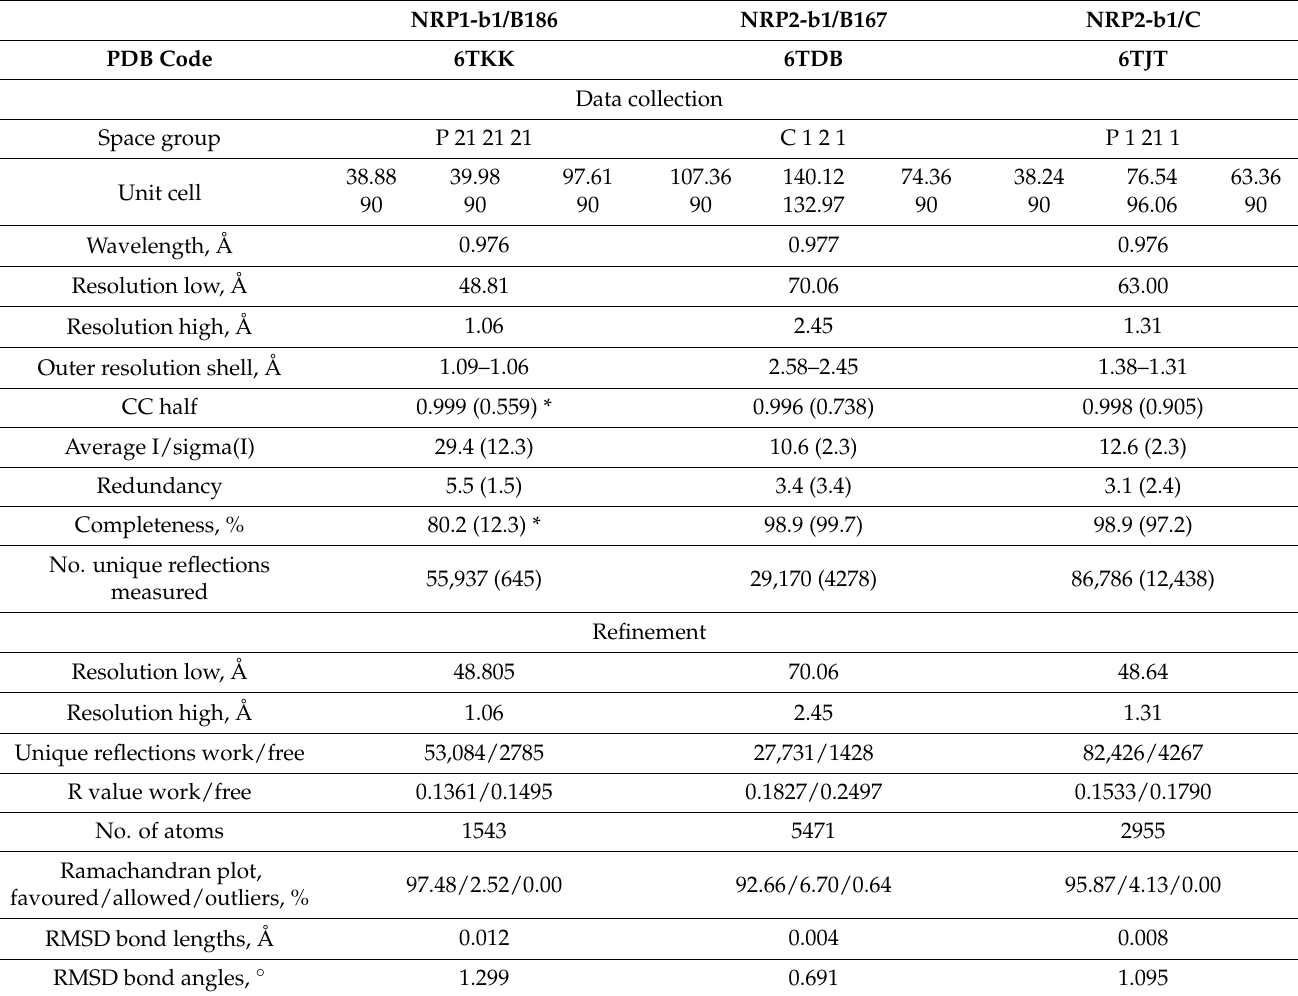
Table 3. Table of crystallographic data and model quality for structures produced in this